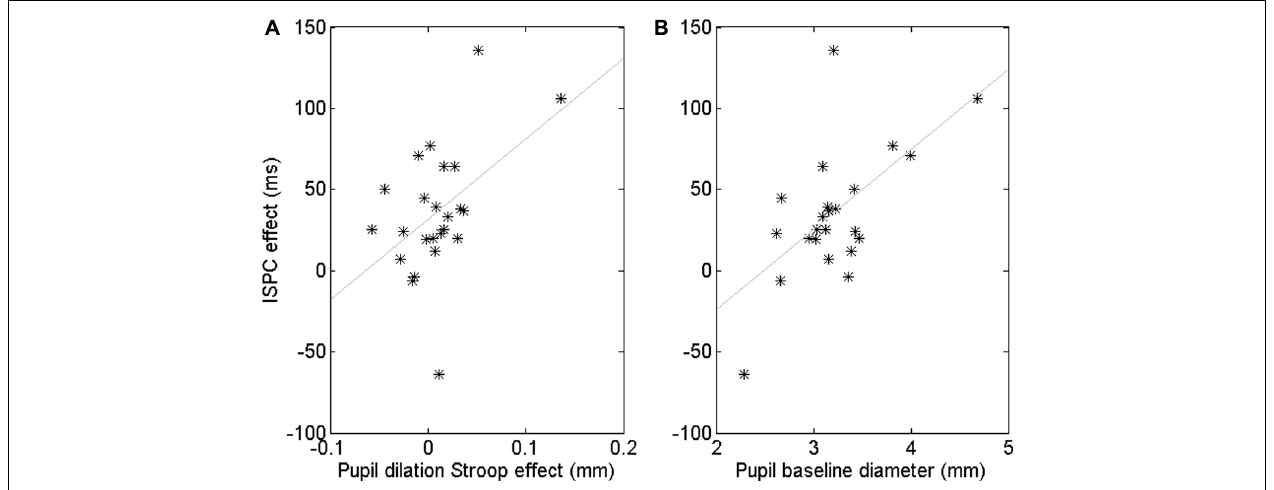
FIGURE 4 | Correlation between the pupil-dilation Stroop effect and the behavioral ISPC effect (A). Correlation between pupil baseline diameter and the ISPC effect (B) . Each star represents one subject.